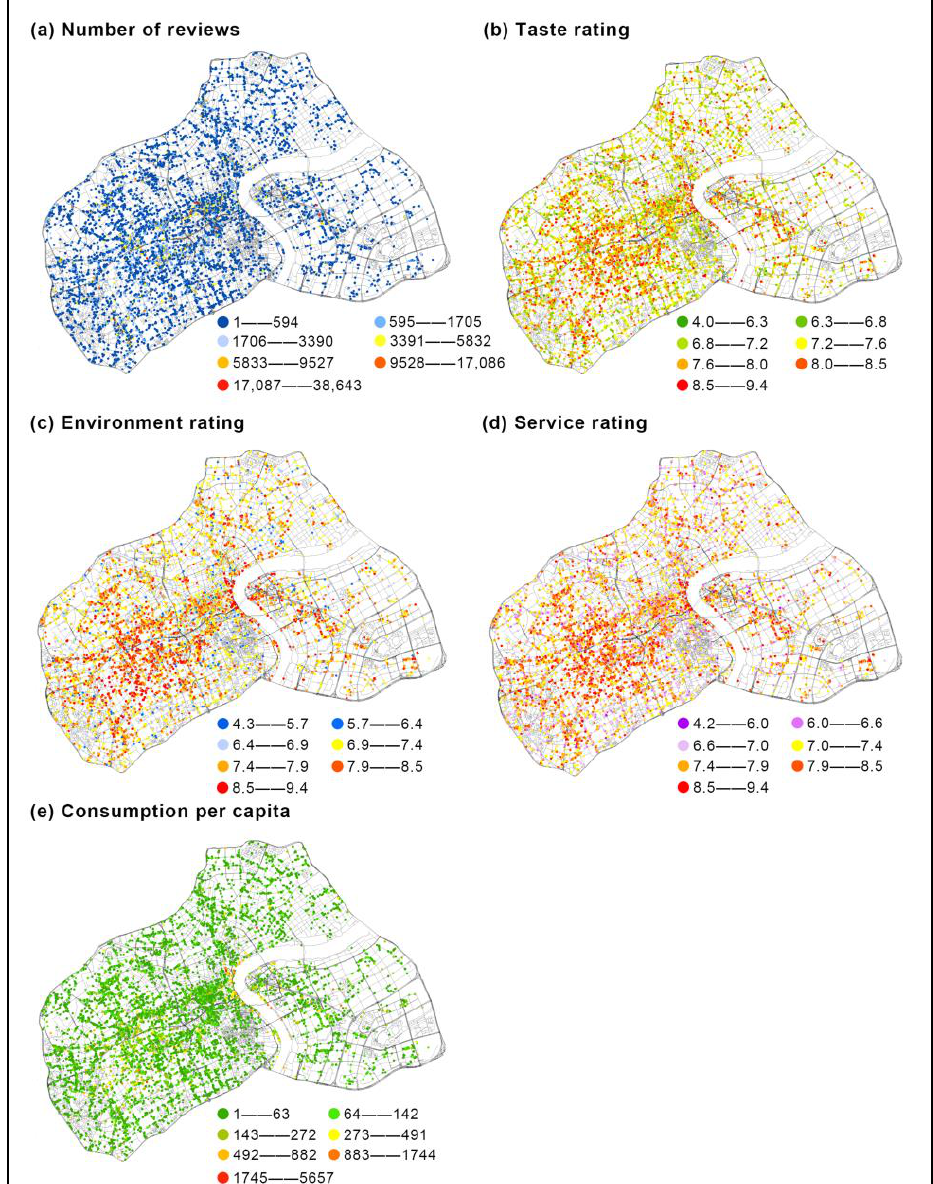
Figure 7. Spatial distribution of the social media data.